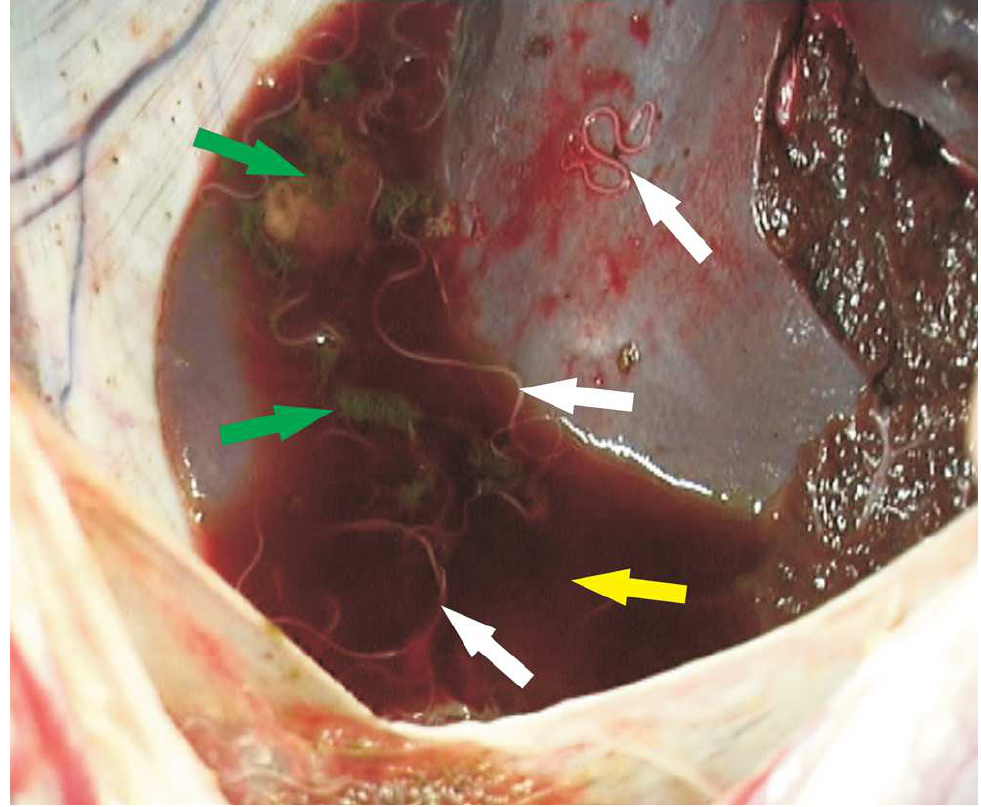
Fig. 4. Ascites fluid (pale arrow) in the peritoneal cavity of a reindeer calf with green fibrin formation (dark arrows) and Setaria tundra nematodes (white arrows).